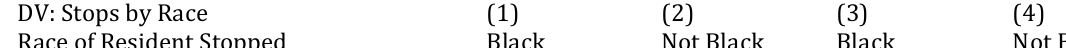
Table 2. Relationship between Local Homicides and Stops, by Race of Resident Stopped (2006–9) DV: Stops by